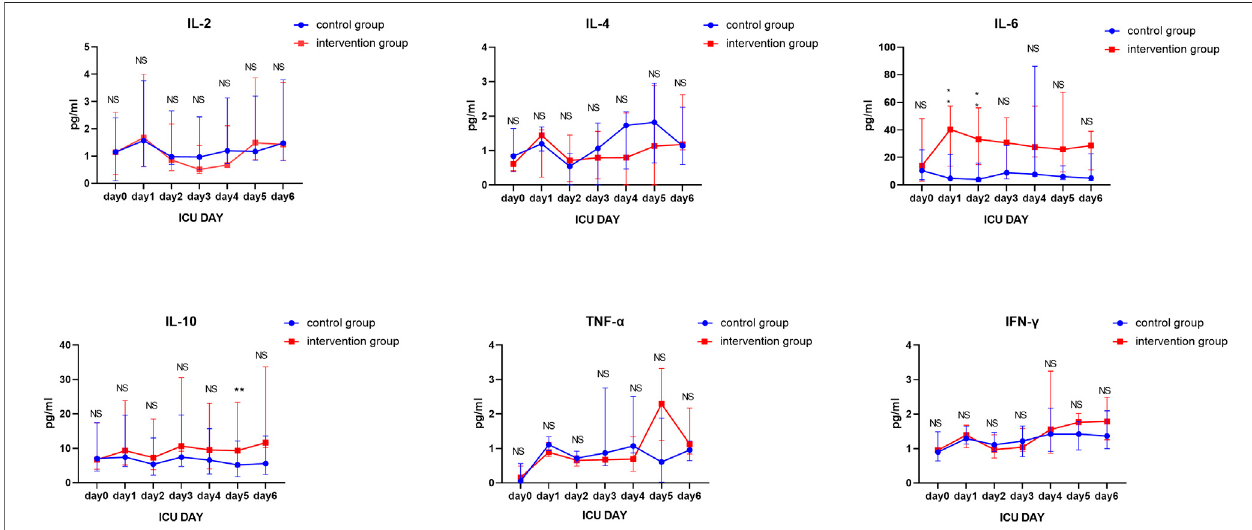
FIGURE 2 | Longitudinal comparison of IL-2, IL-4, IL-6, IL-10, TNF- α , and IFN- γ concentrations between the two groups from day 1 to day 6.